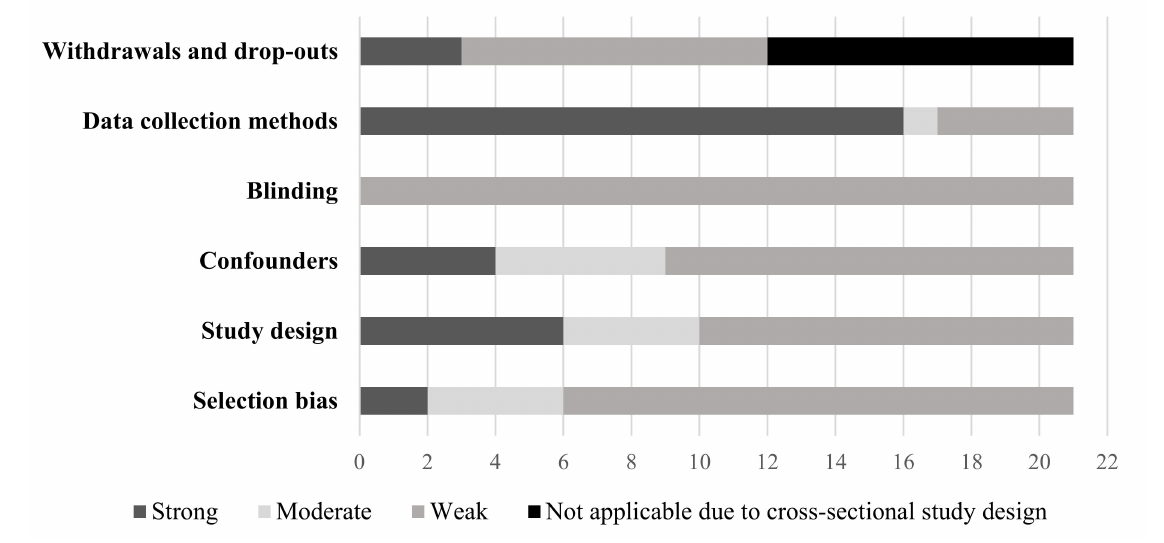
Figure 2. Quality of quantitative studies by assessment item—Social and Emotional Development.